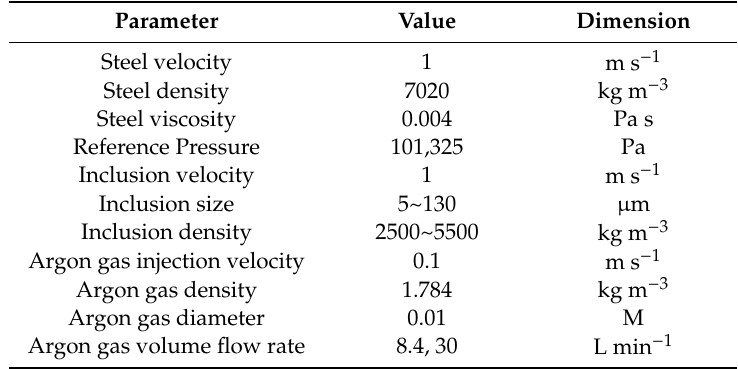
Table 2. Process parameters and physical properties used for CFD